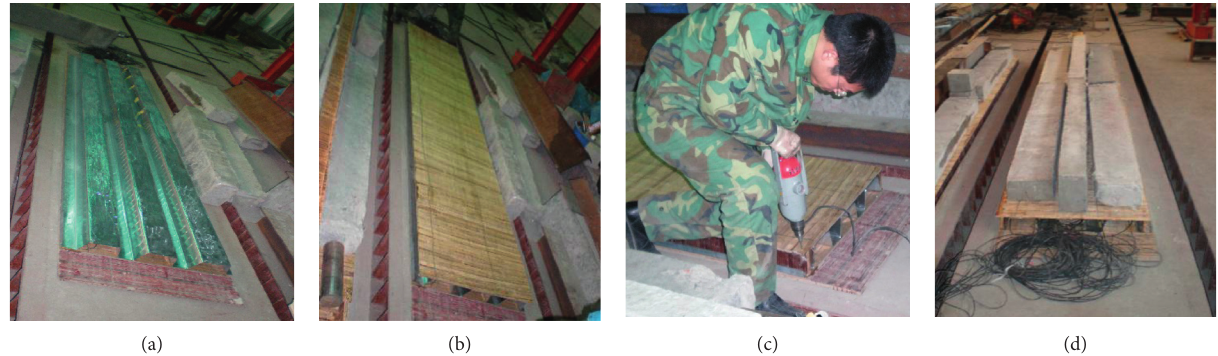
Figure 5: Specimens processing. (a) Wiring and gluing. (b) Assembling. (c) Screwing. (d)